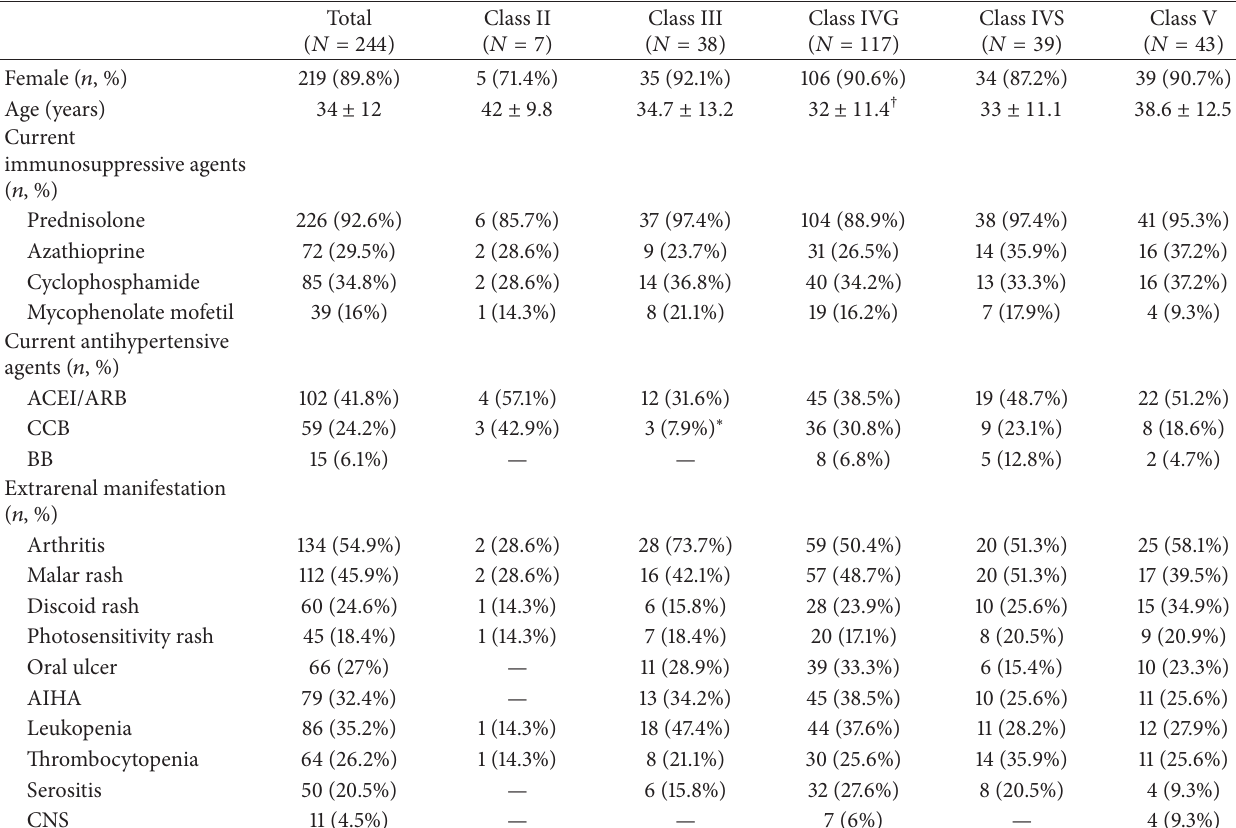
Table 1: The demographic and clinical findings at renal biopsy by LN